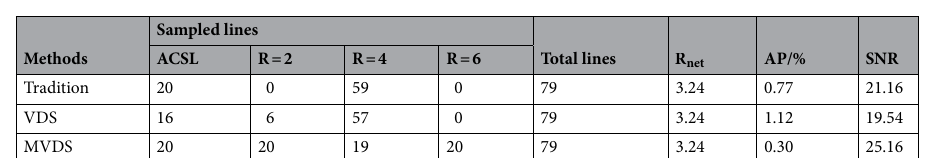
Table 2. The comparison of reconstruction images sampled using traditional method, VDS method, or MVDS method with different schemes.